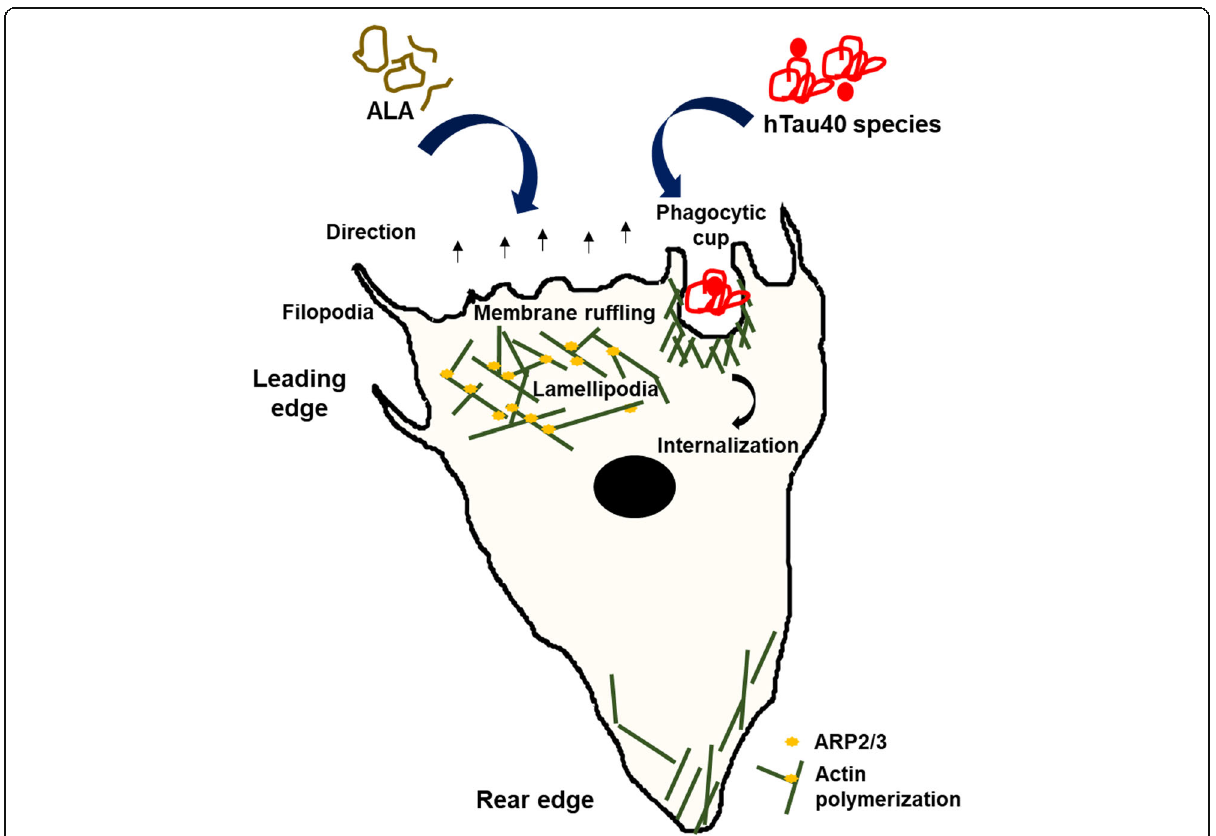
Fig. 7 α -Linolenic acid as a modulator of actin cytoskeleton for phagocytosis and migration of microglia. The picture representation suggests effects of ALA after exposure to microglial cells in enhancing extracellular Tau phagocytosis and associated actin-remodeling. ALA enhances phagocytosis of microglia with increased actin dynamics, the actin structure lamellipodia, and filopodia for the migration and promotes membrane ruffling to support the process of